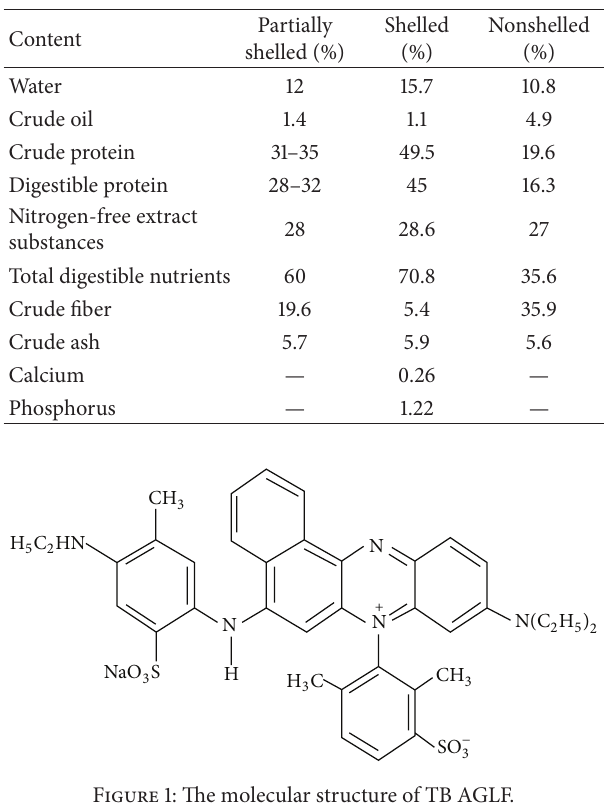
Table 1: The chemical structure of sunflower pulp.